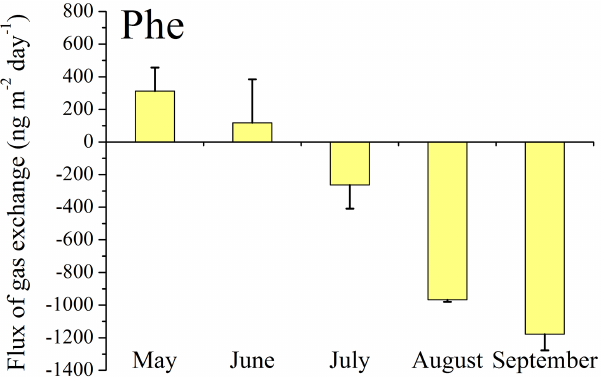
Figure 8. Reversal of the air–water gas exchange for Phe from May to